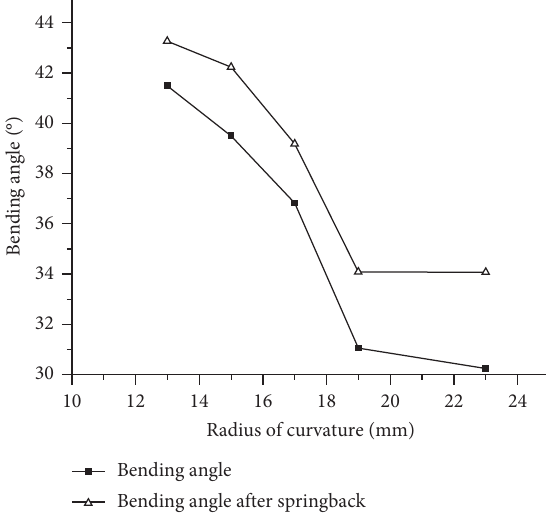
Figure 15: Curves of von Mises stress after springback.